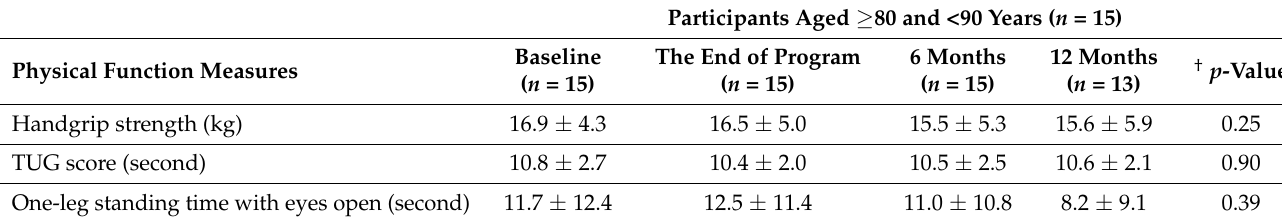
Table 3. Changes in physical function in older participants aged ≥ 80 and <90